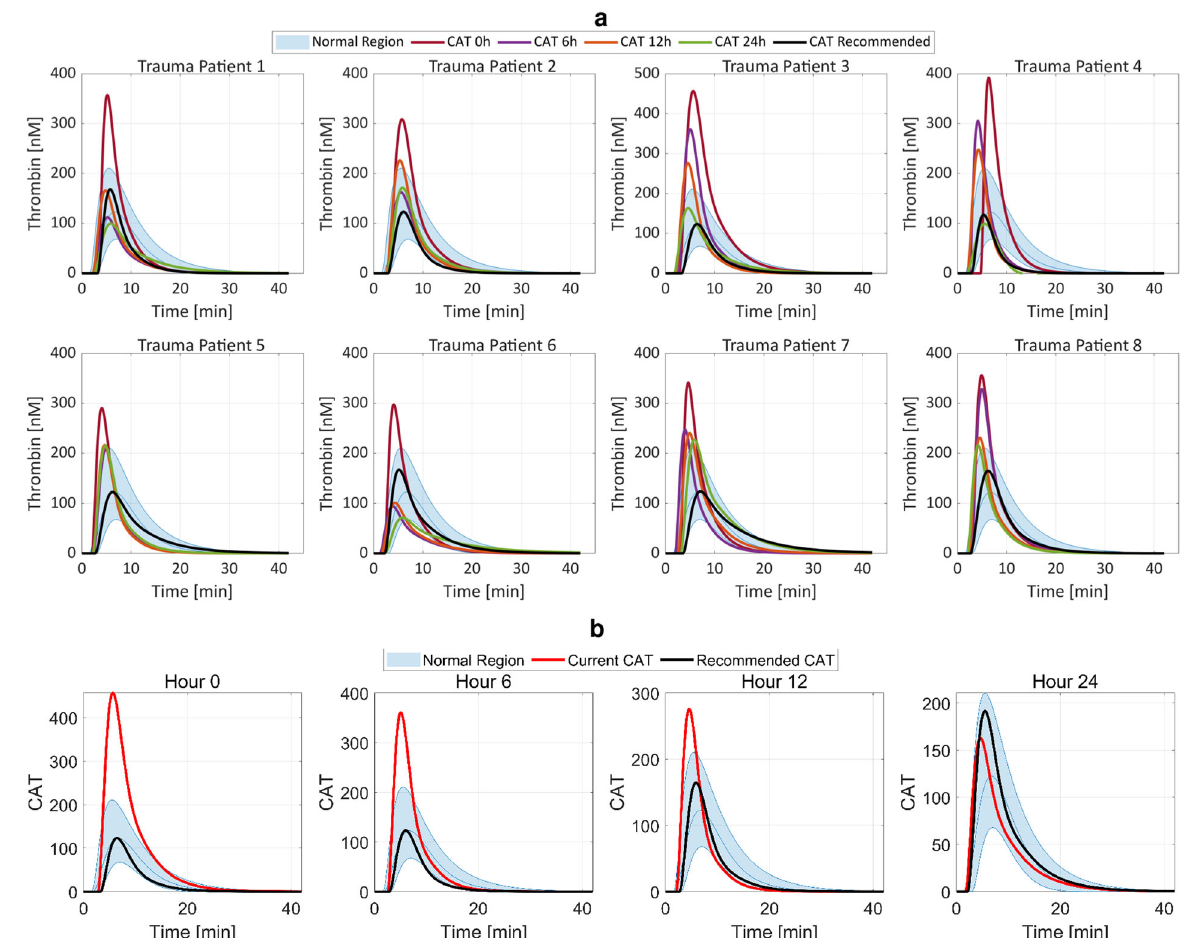
Fig. 9 Our proposed GCM algorithm recommendations drive thrombin generation toward a normal region over time for eight trauma patient samples, validating the correctness and performance of the algorithm. a Estimated CAT trajectory from coagulation factor measurements for eight trauma patients over 24 h. The black line shows the GCM algorithm-recommended patient-speci fi c CAT trajectory at 24 h if following the personalized coagulation factor recommendations for each patient. All recommended trajectories are visible inside normal ranges. Following the GCM algorithm recommendations shows desirable improvements over actual treatment received by eight trauma patients, in both CAT properties that are quantitatively compared to the normal region criteria (Supplementary Fig. 12a and b), and coagulation factor concentrations (Supplementary Fig. 12c and d). b Illustrative estimated CAT trajectory [nM] from coagulation factor measurements for Trauma Patient 3 at different instances over the fi rst 24 h following hospital admission. The black line shows the GCM algorithm-recommended patient-speci fi c CAT trajectory compared to the red line representing the actual CAT. This shows how the GCM algorithm dynamically adjusts the recommendations based on the most recent coagulation factor concentration measurements to move